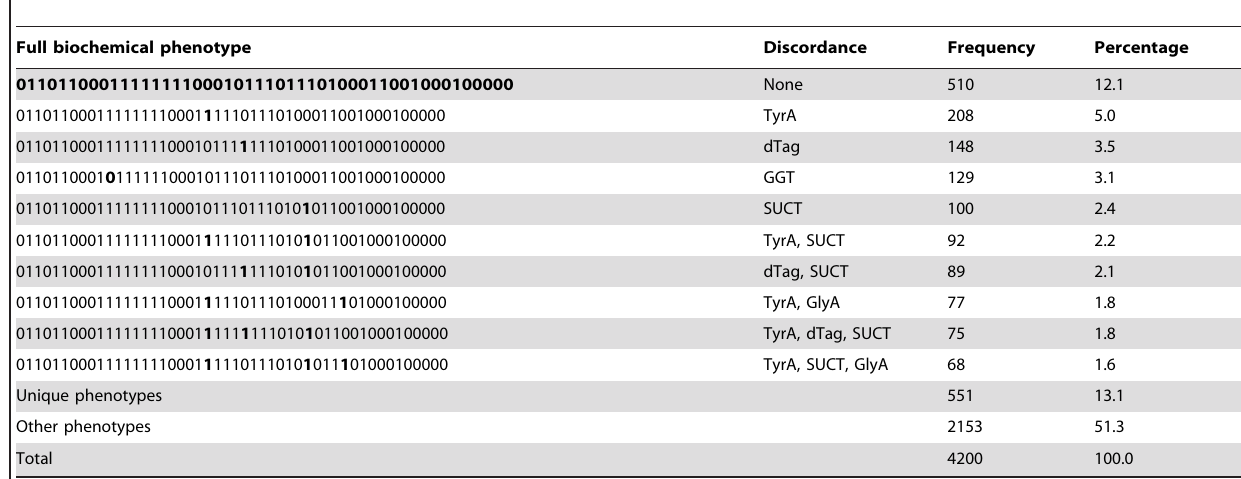
Table 2. Frequency of bionumbers of Klebsiella pneumoniae isolated from specimens collected January 2009-December 2011 considering the full biochemical